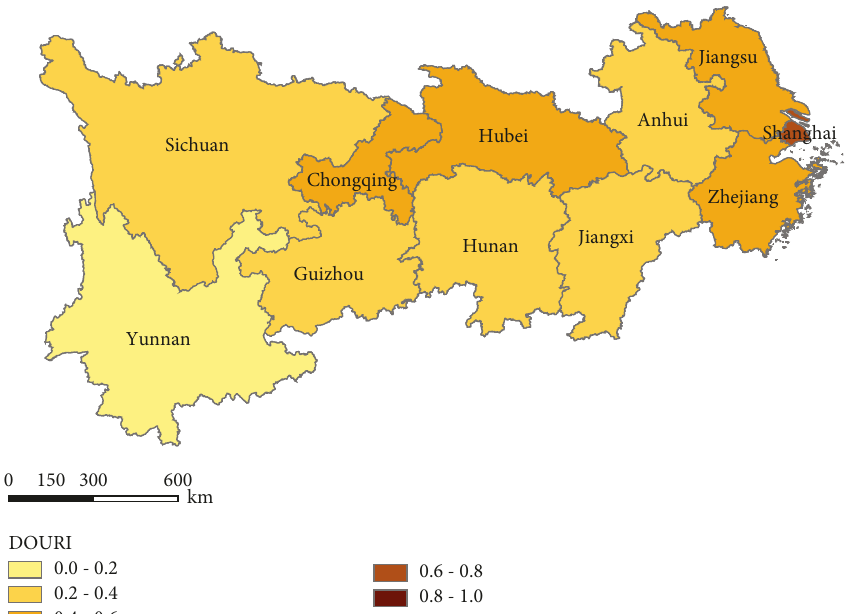
Figure 2: Spatial distribution map of the urban-rural integration degree of the Yangtze River Economic Belt in